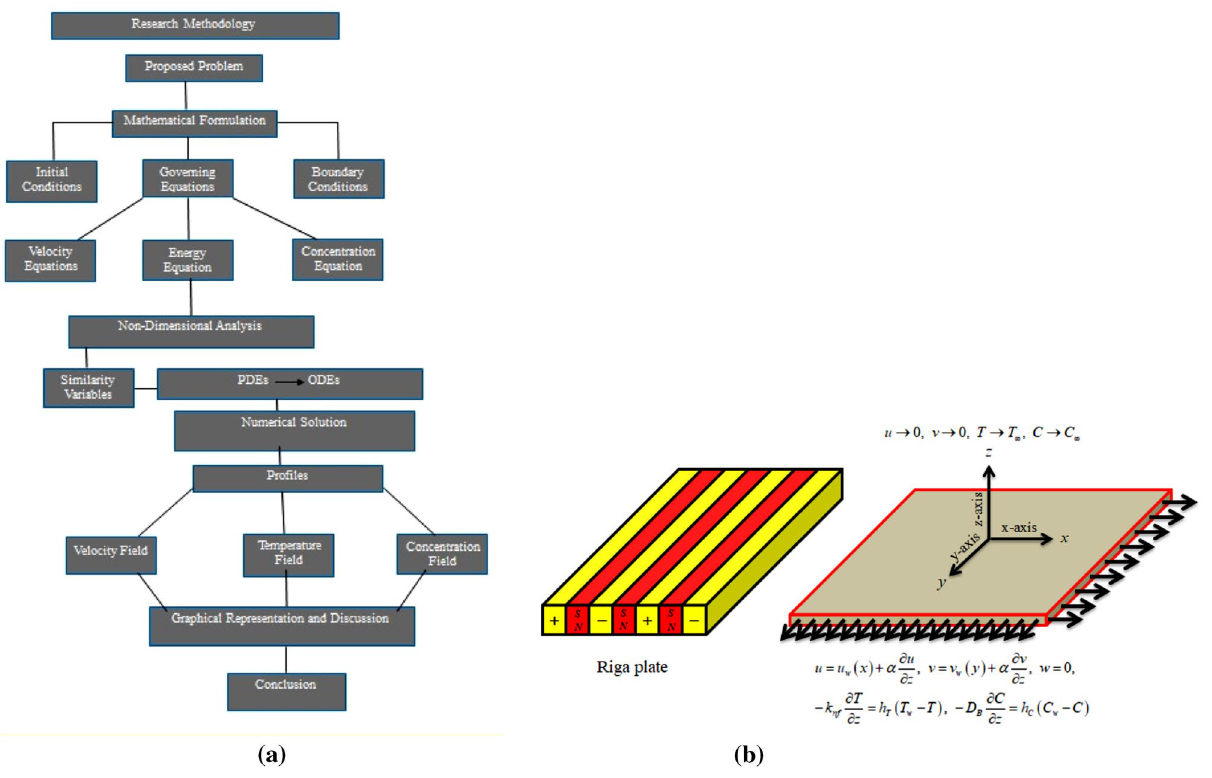
Figure 1. ( a ) Flow chart. ( b ) Flow